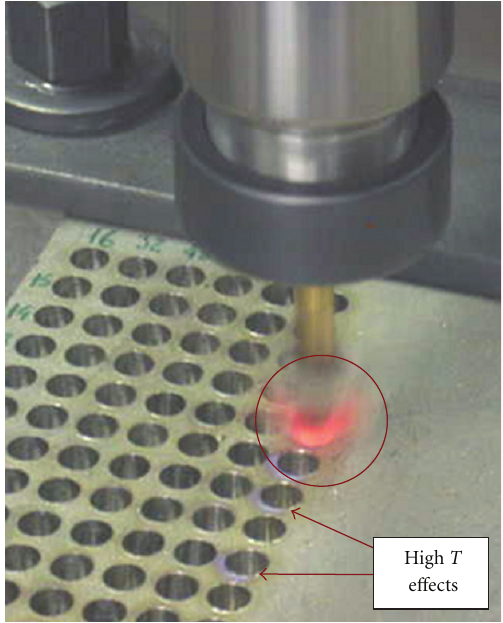
Figure 2: Ti chips combustion during a dry drilling process. Notice the coloured circles around the holes caused by the high cutting